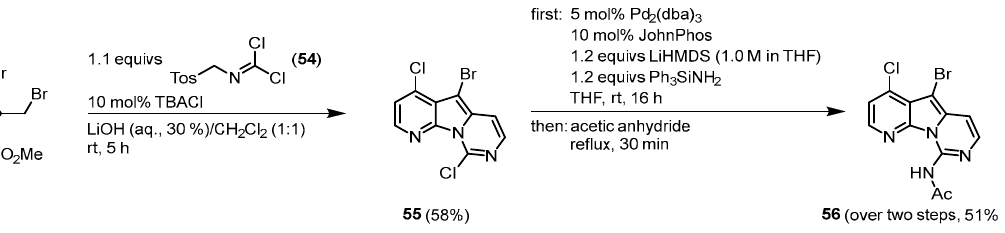
Figure 10. Synthesis of variolin B ( 1 ) via Stille coupling as a key reaction step [47].